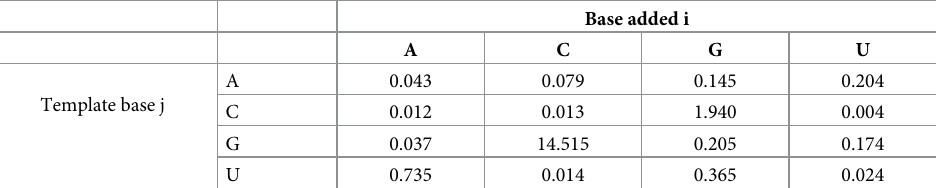
Table 1. Experimental rates of monomer addition r measured by [11] and